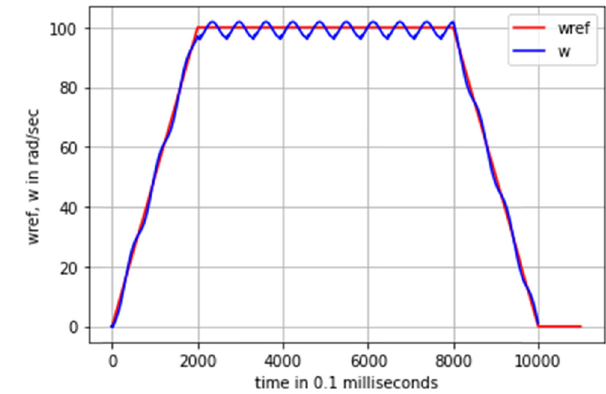
Figure 10: Response of LR control system to disturbance magnitude of 3 × 10 − 2 .